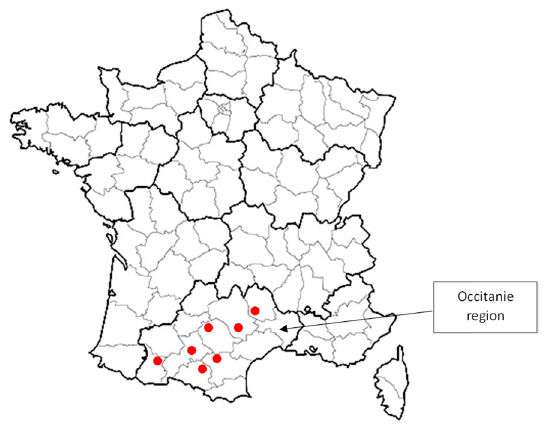
Figure 1. Geographical distribution of the pasta samples in Occitanie region .